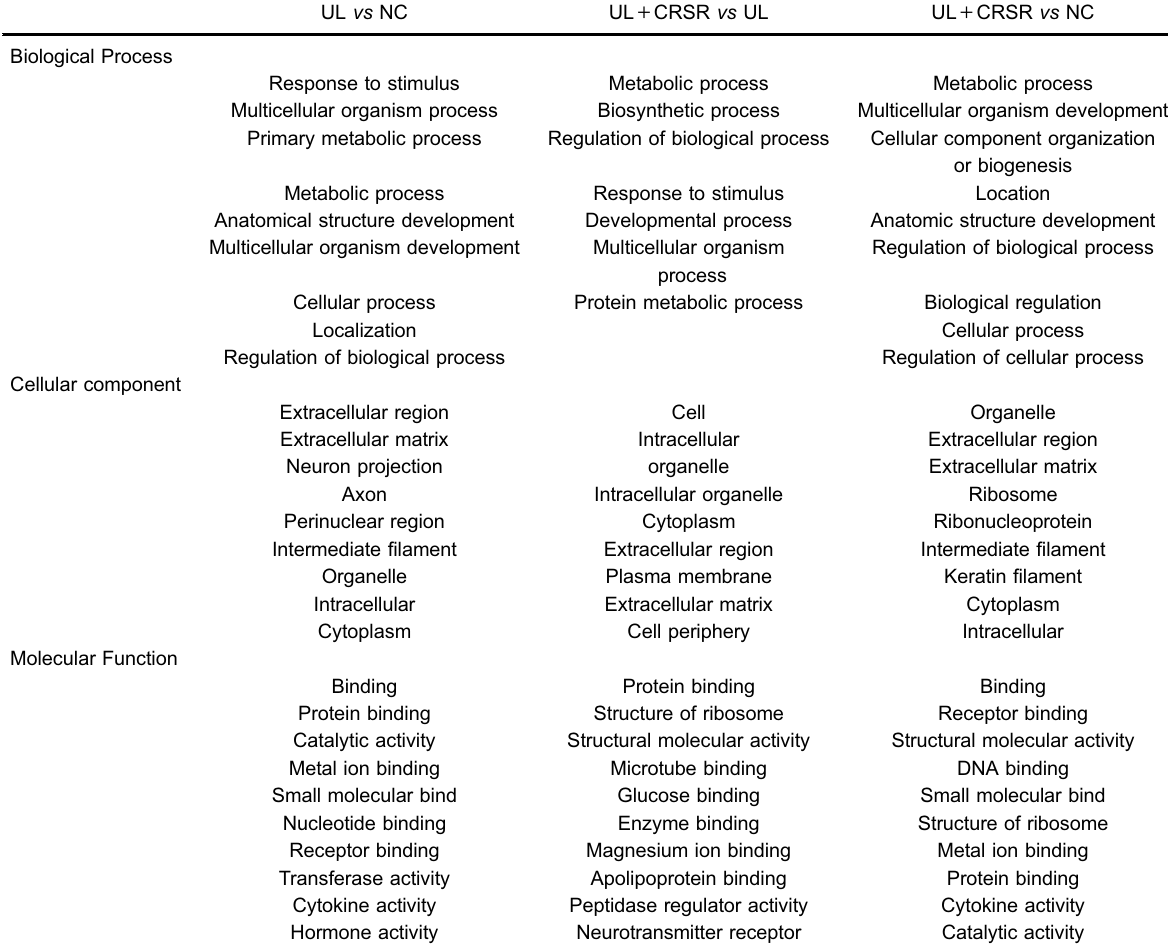
Table 2. Gene ontology (GO) analysis of the differently expressed